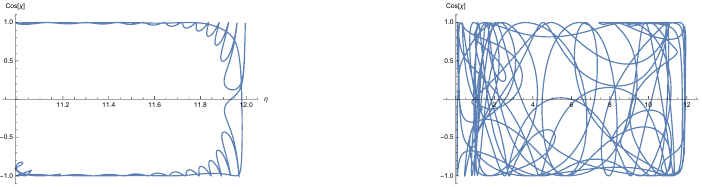
Figure 6 . Plots of trajectories in the (cid:17) ( (cid:28) ) ; cos( (cid:31) ( (cid:28) )) plane in the Uluru space time. Left we have E = 0 : 1 with see trajectory con(cid:12)ned to the region of space to 11 < (cid:17) < 12 and on the right with E = 5 : 0 the trajectory wildly explores all of space.